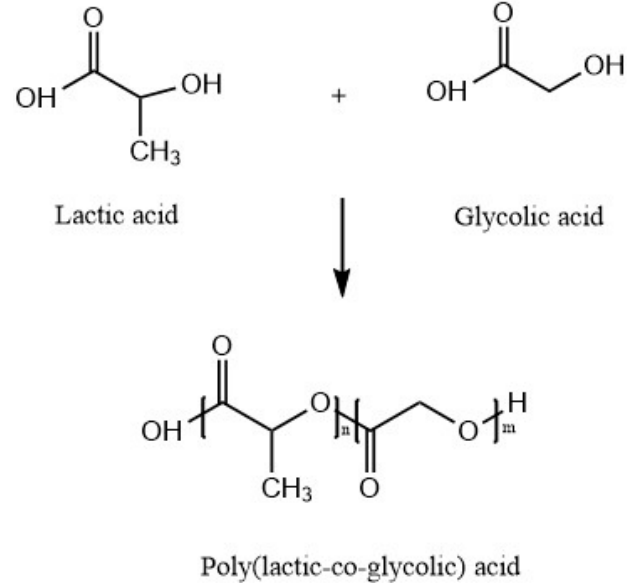
Figure 6. Poly(lactic- co -glycolic acid) (PLGA) and its constituent monomers, lactic and glycolic acid.